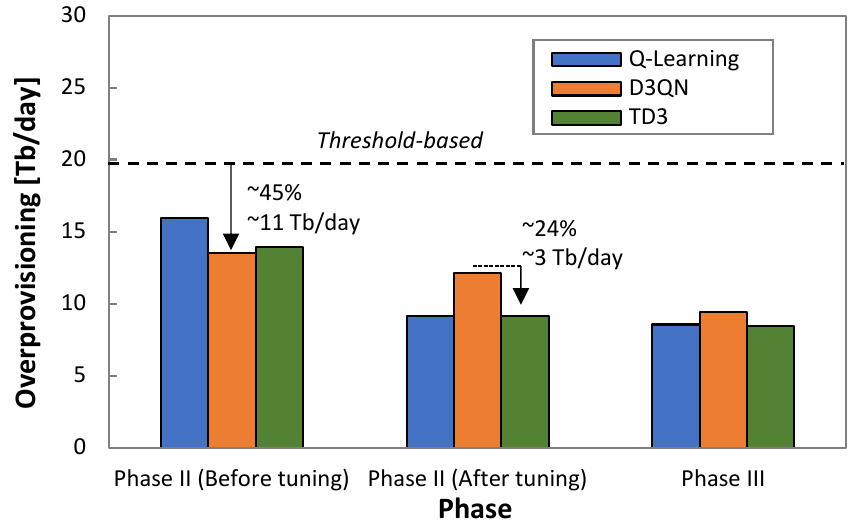
Figure 14. Phase II: QoS ( a ) and ρ ( b ) evolution.